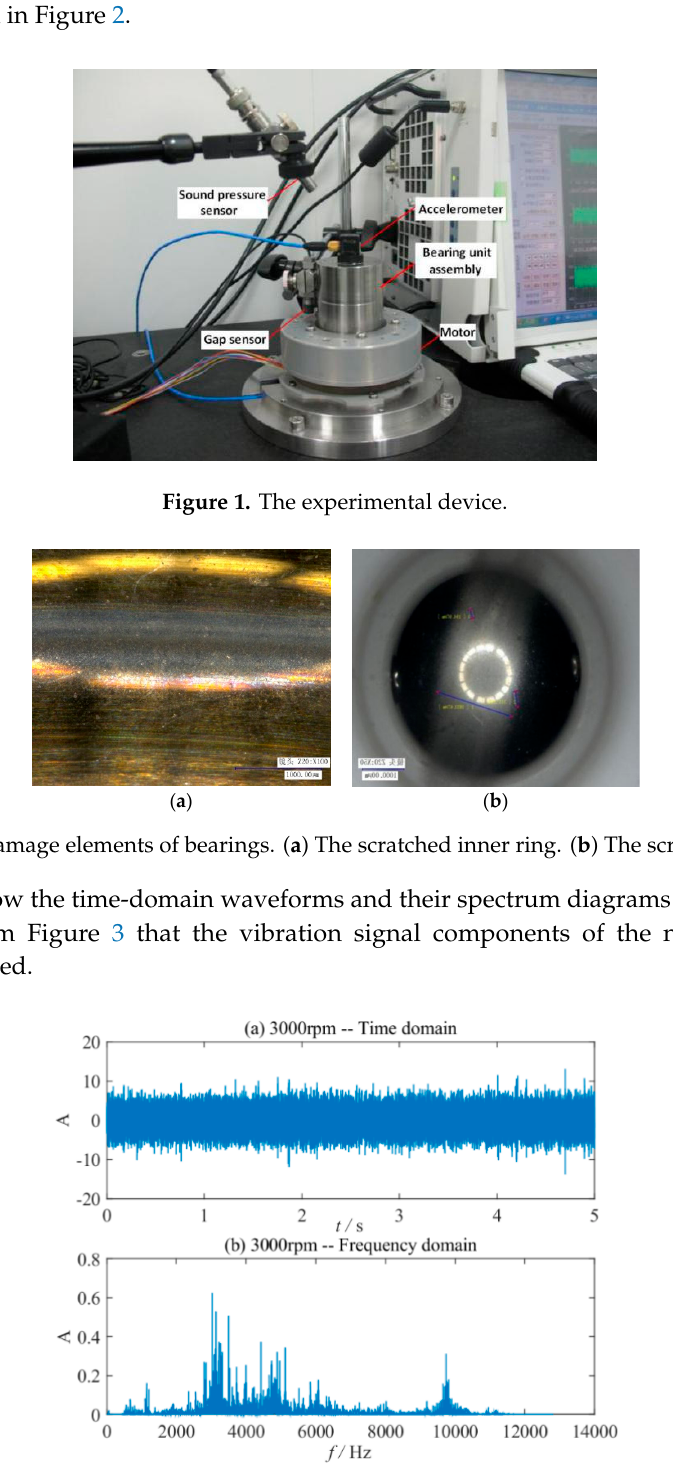
Figure 3. Normal bearing vibration signal. ( a ) The time-domain waveform at 3000 rpm; ( b ) the Figure3. Normalbearingvibrationsignal. ( a )Thetime-domainwaveformat3000rpm; ( b )thefrequency frequency spectrum at 3000 rpm. spectrum at 3000